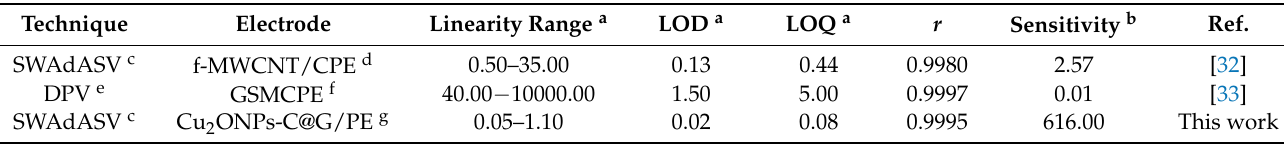
Table 3. Comparison of different analytical parameters of the proposed method with other voltametric methods used for MEB